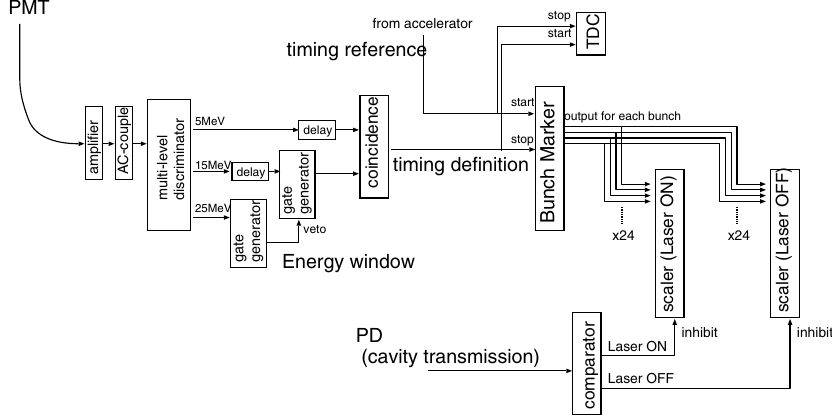
FIG. 3. Schematic diagram of the readout circuits.